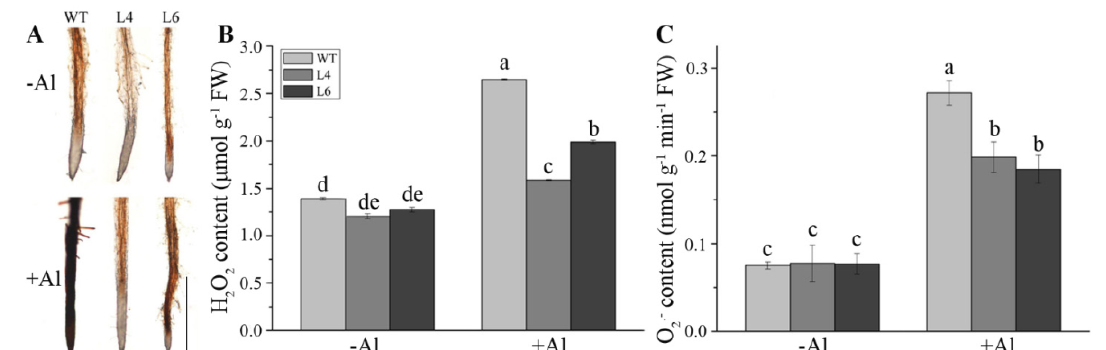
Figure 6. Overexpression of ZmALDH reduces the accumulation of superoxide (O 2 − ) and hydrogen peroxide (H 2 O 2 ). Seedlings of WT, L4, and L6 were grown in the 2% MGRL solution for 14 d, and then plants were treated with 60 µ M AlCl 3 for 12 h, before roots were collected for subsequent experiments: ( A ) Histochemical visualization of H 2 O 2 was performed with DAB staining. Scale bar: 250 µ m. Contents of ( B ) H 2 O 2 and ( C ) O 2 − in WT and transgenic lines after exposure to Al stress for 12 h. Values represent mean ± SD ( n = 20). Different letters indicate significant differences ( p < 0.01) (Tukey’s test).